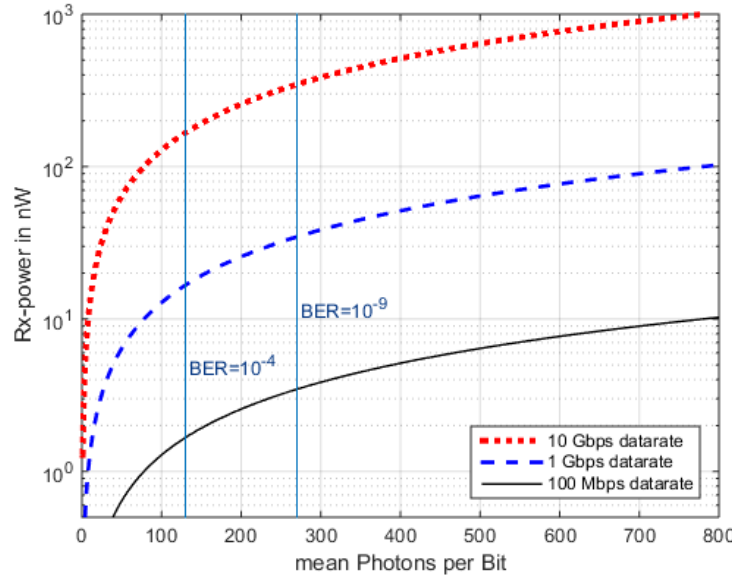
Figure A1. Reference of P Rx vs. Ppb for different data rates for a 1550 nm wavelength, with BER lines as an ideal constant Ppb RFE.